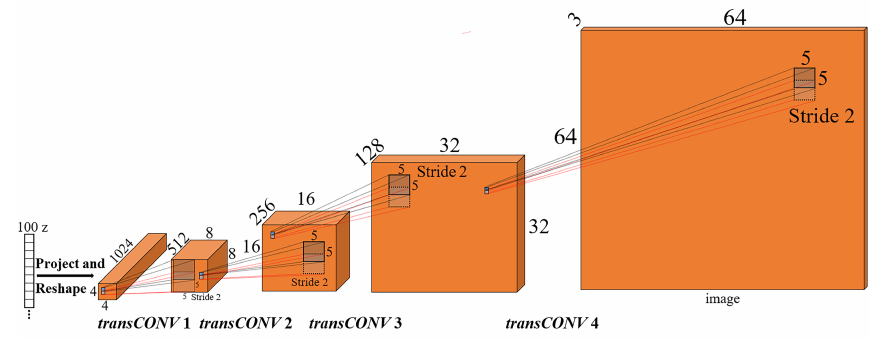
Figure 1. DCGAN: An actual GAN generator for LSUN scene modeling.